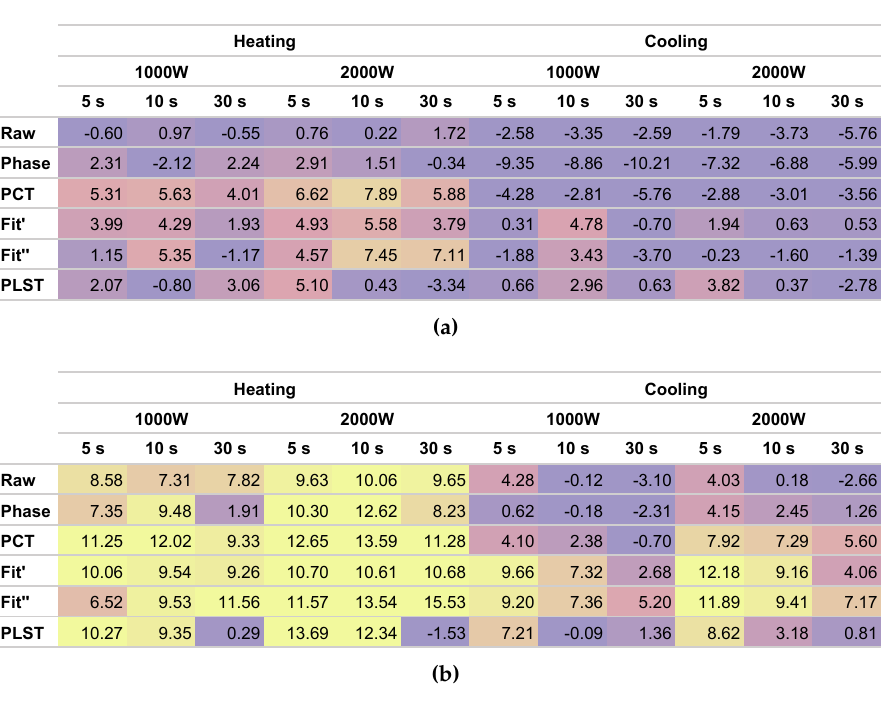
Figure 10. Quantitative results of the inspection for the considered periods, power, stimulation time and post-processing methods. All values are expressed in dB. ( a ) Side A with impact damage